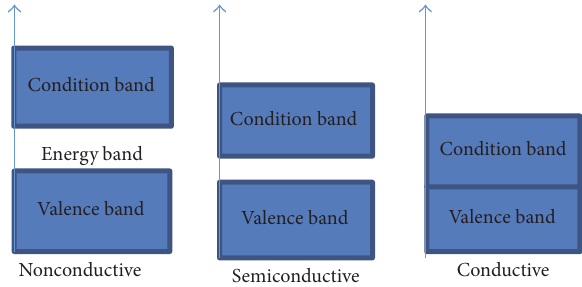
Figure 2: Energy gap in semiconductive, nonconductive, and conductive